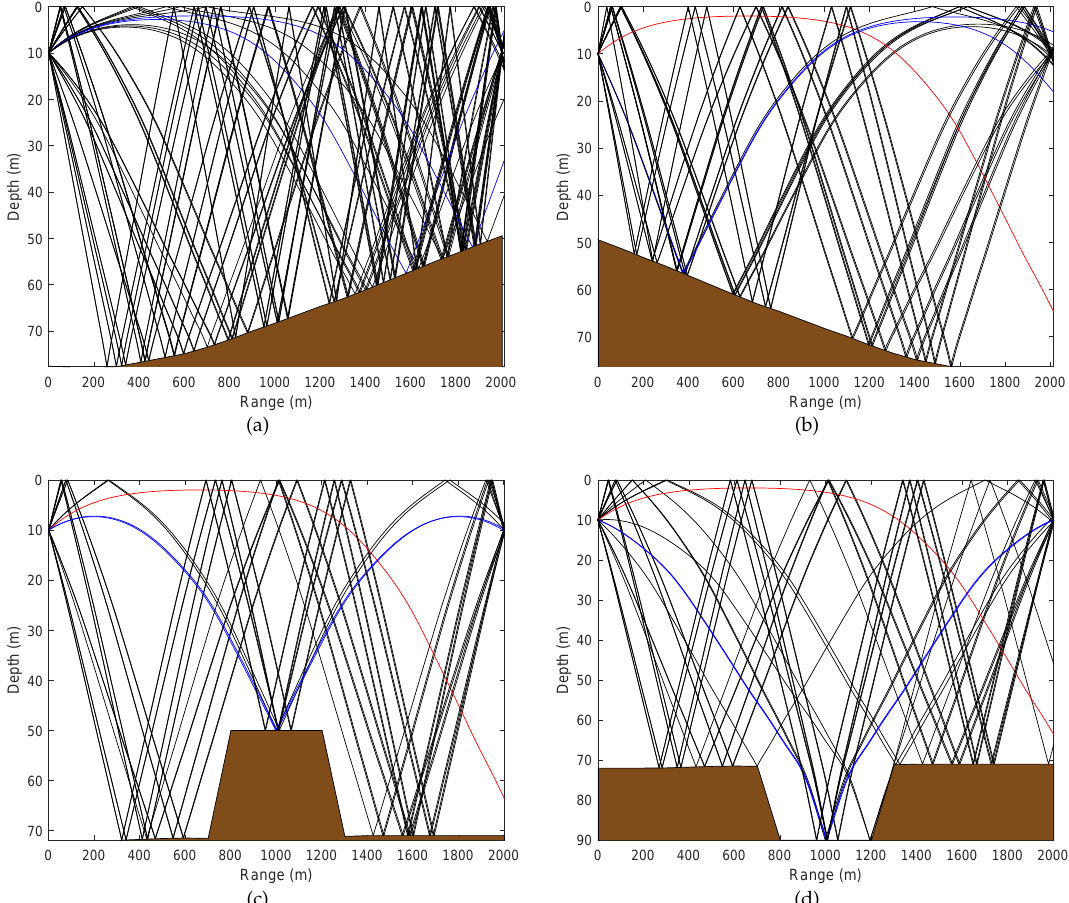
Figure 9. Eigenrays of channel with different sea bottom boundaries. The color of lines indicates whether eigenrays hit surface boundary or bottom boundary of the sea. Sea bottom boundaries of each figure: ( a ) rising bottom; ( b ) falling bottom; ( c ) protruding bottom; ( d ) sagged bottom.